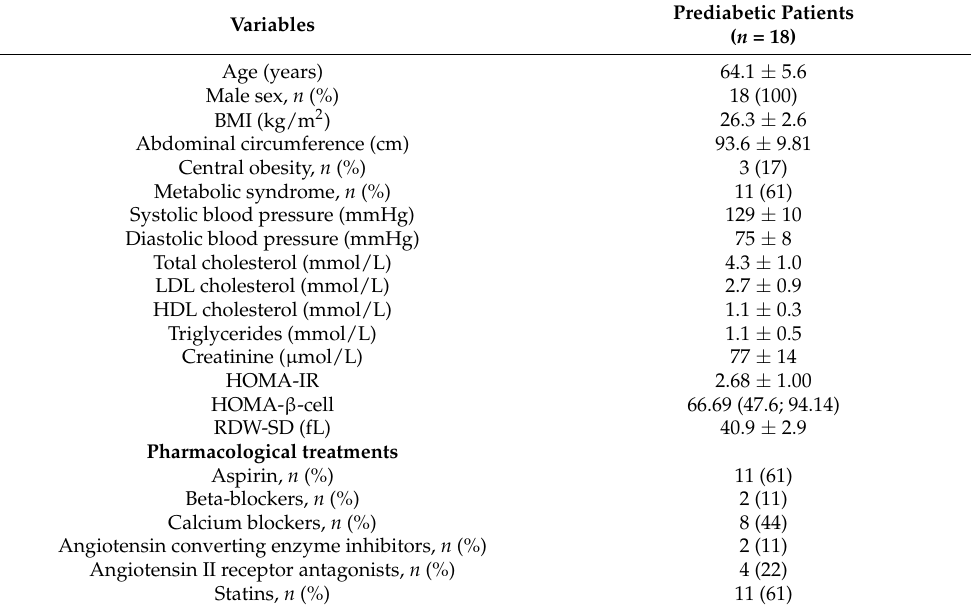
Table 1. Baseline demographic and clinical characteristics of the study population.